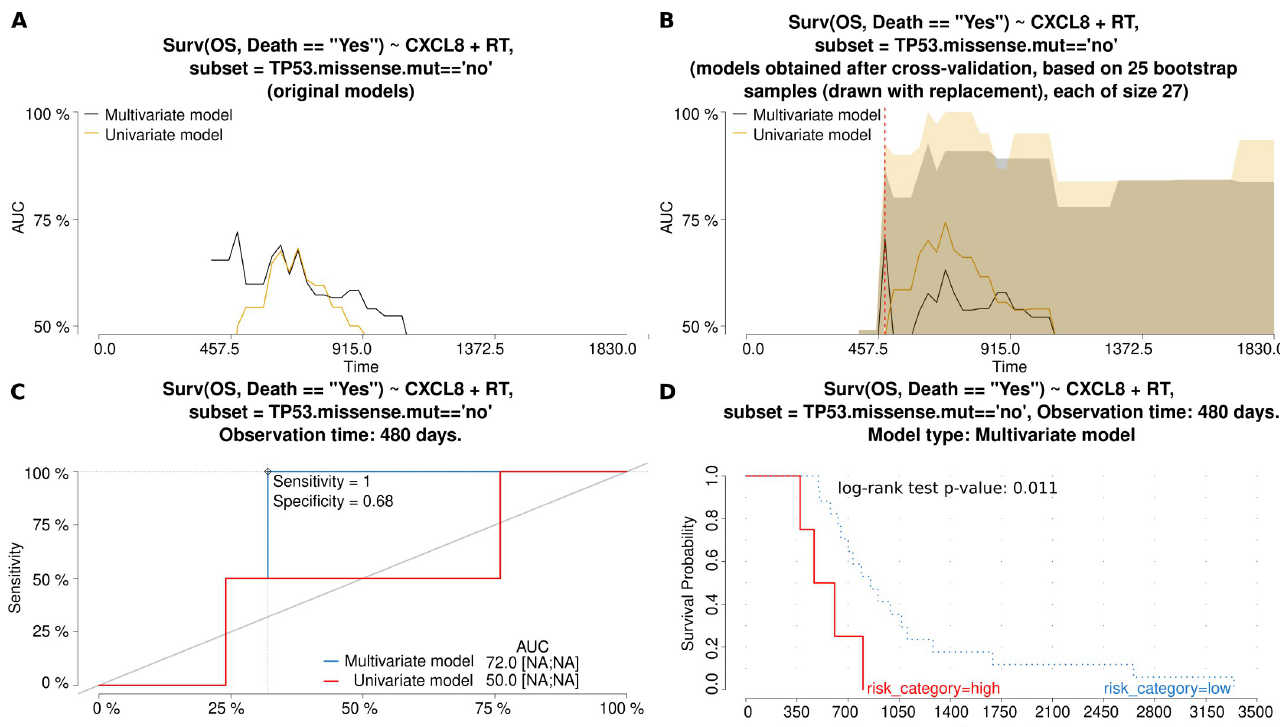
Fig 2. Characteristics and comparison of the Cox regression models (gene: CXCL8 ). The models allowed for the assessment of the risk of death , depending on either a single independent variable ( CXCL8 mRNA expression (exp)–the univariate model or three independent variables (exp, FIGO and RT)–the multivariate model. Fig A and B show how the AUC values (and thus also discriminating abilities of each model) change in time for original models (A) and models obtained after a bootstrap-based cross-validation of the original data set (B). The bigger the AUC, the higher the performance of a model. A red dashed line marks the same time point which was used to draw the time-dependent ROC curve (C) for both models. In Fig C, an optimal cut-off point was calculated for the multivariate model based on the Youden index. Sensitivity and specificity for this cut-off point are also provided. In addition, AUC values [%] are listed alongside the 95% CI values, shown in square brackets, if calculable. Fig D depicts the Kaplan-Meier survival curves obtained for the multivariate model at the same time point as in the remaining plots. The risk was classified as either higher (high) or lower (low) than in the cut-off point. The Kaplan-Meier curves are supplemented with the result of the log-rank test, as well. Abbreviations used: OS–Overall Survival; RT–Residual